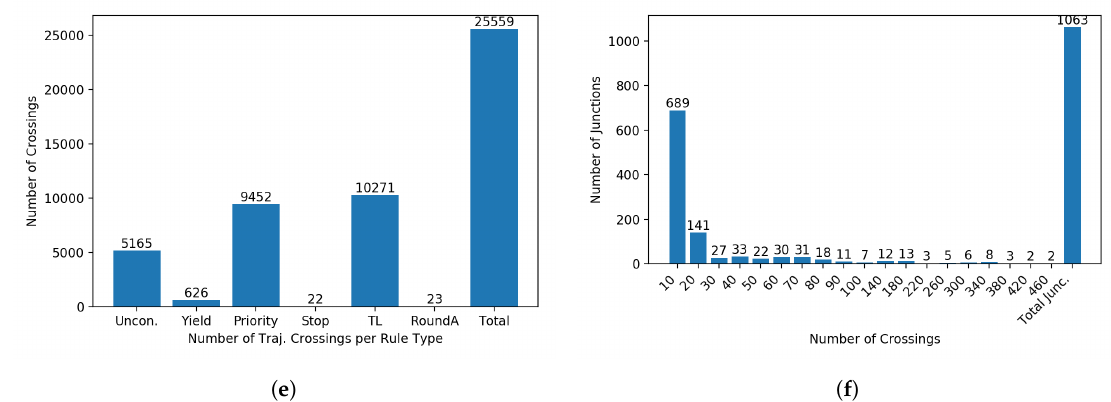
Figure A1. Statistics that describe the dataset used for testing the proposed methodology. ( a ) Distribution of dataset’s trajectories according to their length (Km). ( b ) Distribution of dataset’s trajectories according to trip duration (minutes). (c) Distribution of dataset’s regulators according to their type (junction arms having at least one crossings). ( d ) Distribution of dataset’s intersections according to their shape type. ( e ) Distribution of dataset’s trajectories according to the regulator type of the junctions they cross. ( f ) Distribution of dataset’s intersections according to the number of trajectories they cross each of